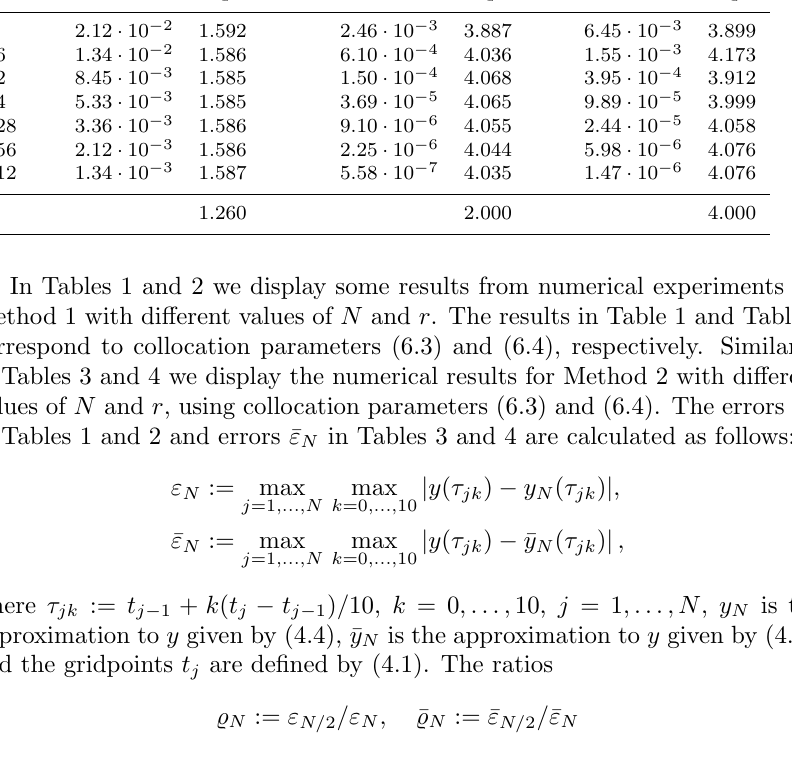
Table 1. Numerical results for problem (6.1)–(6.2) using Method 1, with collocation points (6.3) and m = 2. r = 1 r = 3 r = 6